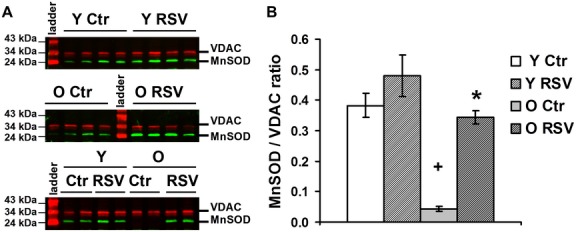
RSV increases the expression of anti-oxidant enzymes in brain mitochondria.Expression of MnSOD was analyzed by Western blotting (normalised to the quantity of VDAC protein) on mitochondrial fractions from young (Y) and old (O) control (Ctl) and RSV-treated mice. (A) Representative blot of two duplicate experiments on n = 4 animals. (B) Quantification of MnSOD expression. Data are represented as means ± sem of four animals in duplicate. The (+) indicates significant differences (p<0.05) between young and old animals and the (*) shows a significant effect of the RSV-diet (p<0.05).